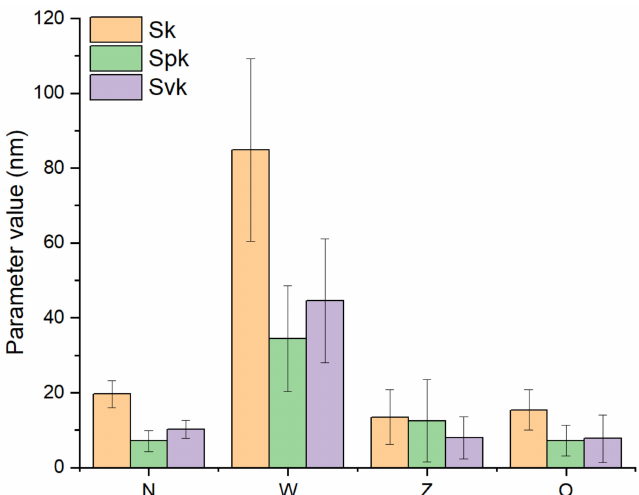
Figure 5. Graphs showing the values of functional parameters of the surface texture describing thicknesses of the surface components: core (Sk), peaks (Spk) and valleys